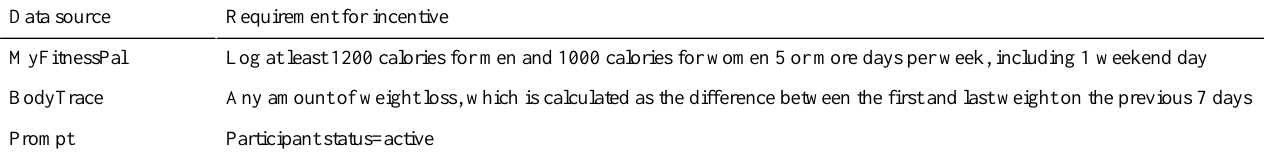
Table 1. Incentive